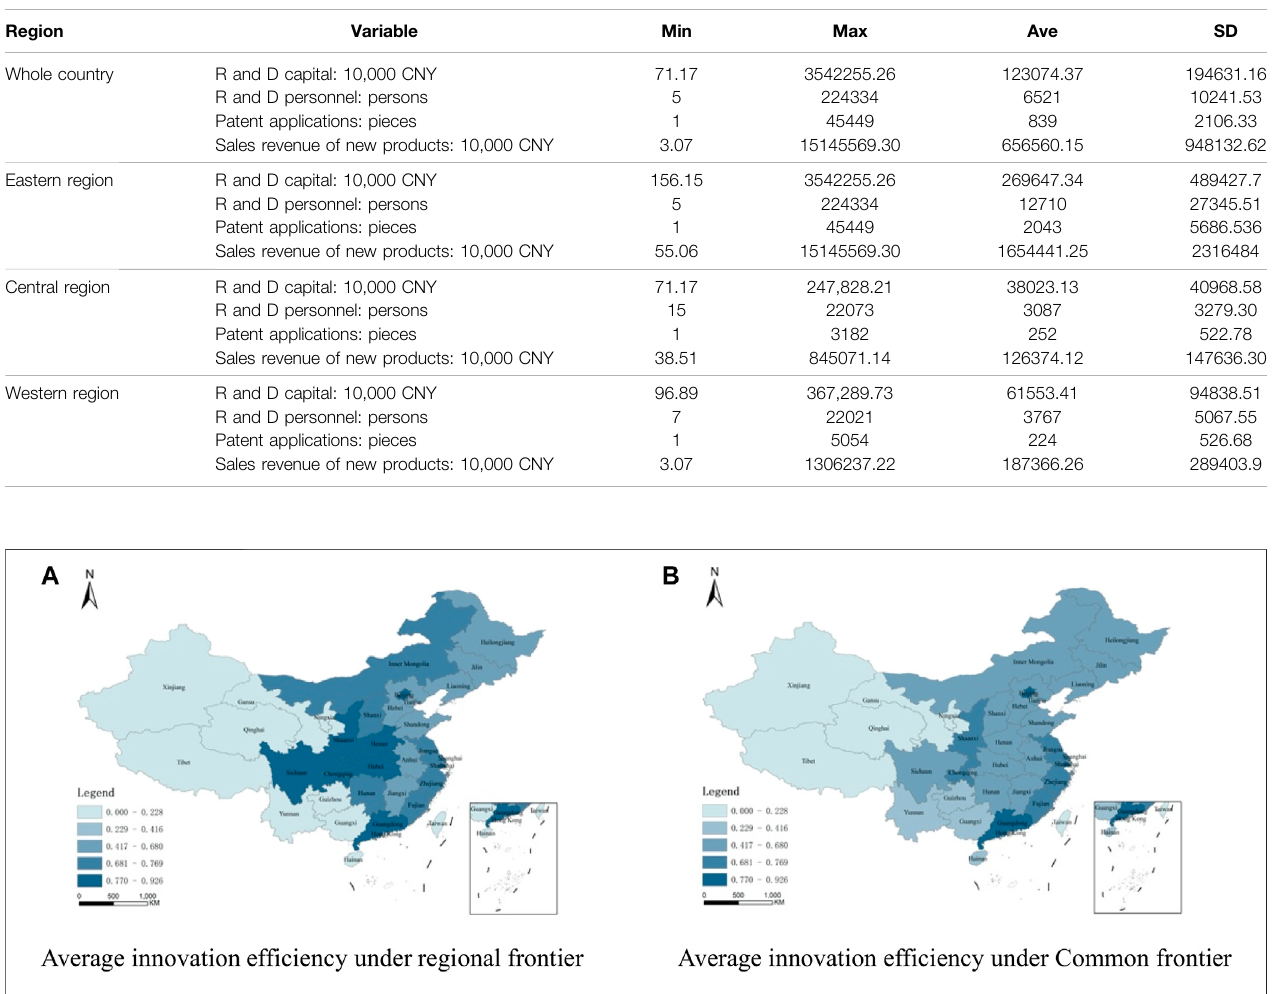
FIGURE 1 | Average innovation ef fi ciency of the high-tech industry under the regional Frontier and the common Frontier in 1999 –